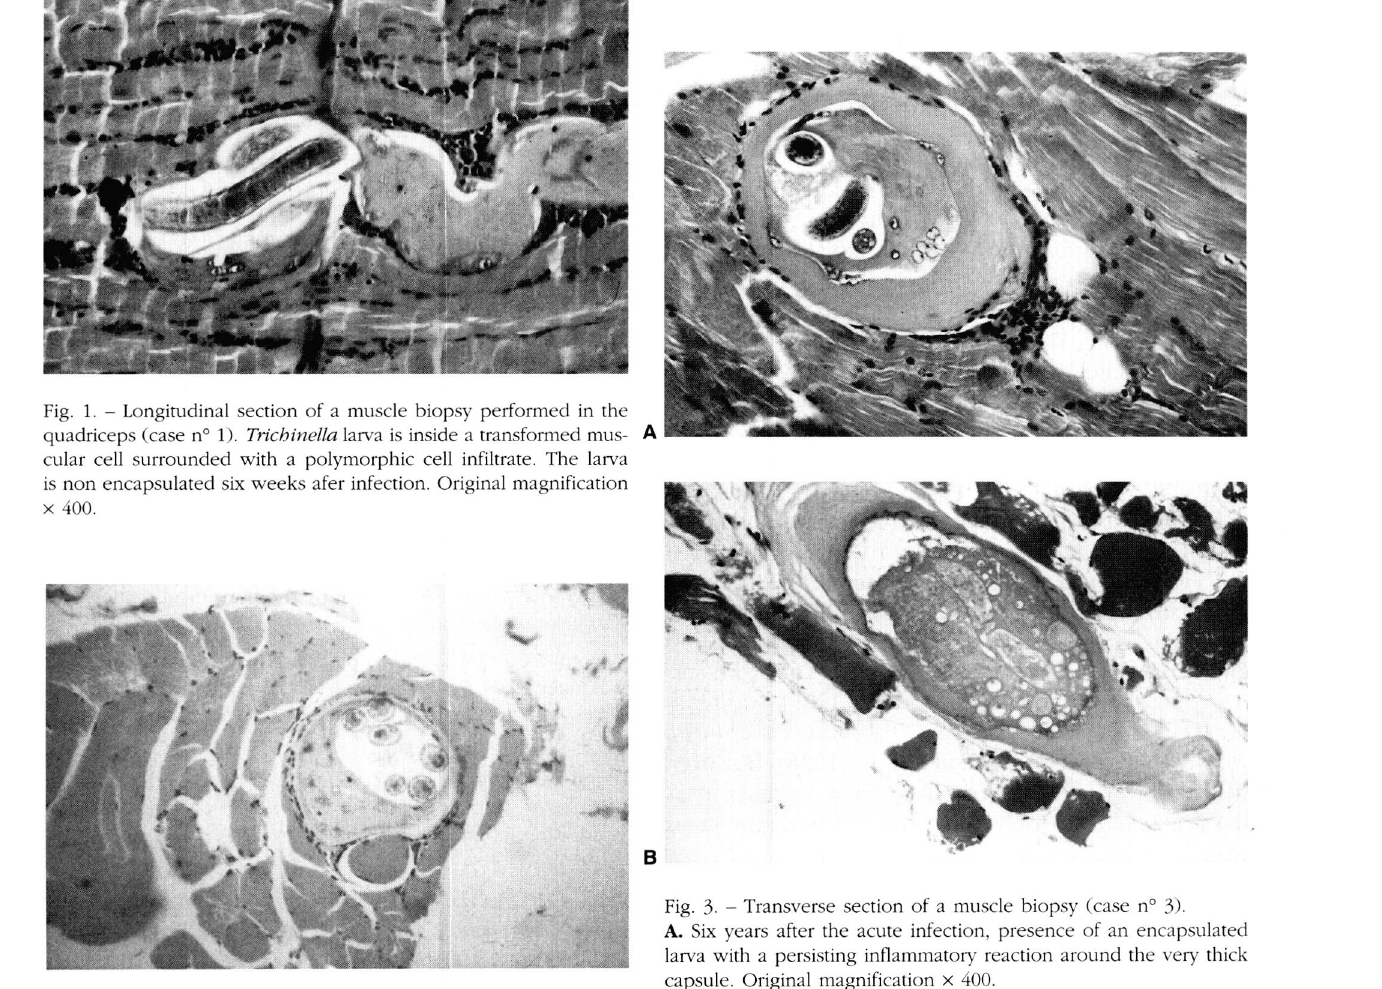
Fig. 2. - Cross section of a muscle biopsy (case n° 2). Ten weeks after infection, the larva is now encapsulated. The cytoplasm of the nurse cell contains enlarged nuclei. Original magnification x 400.